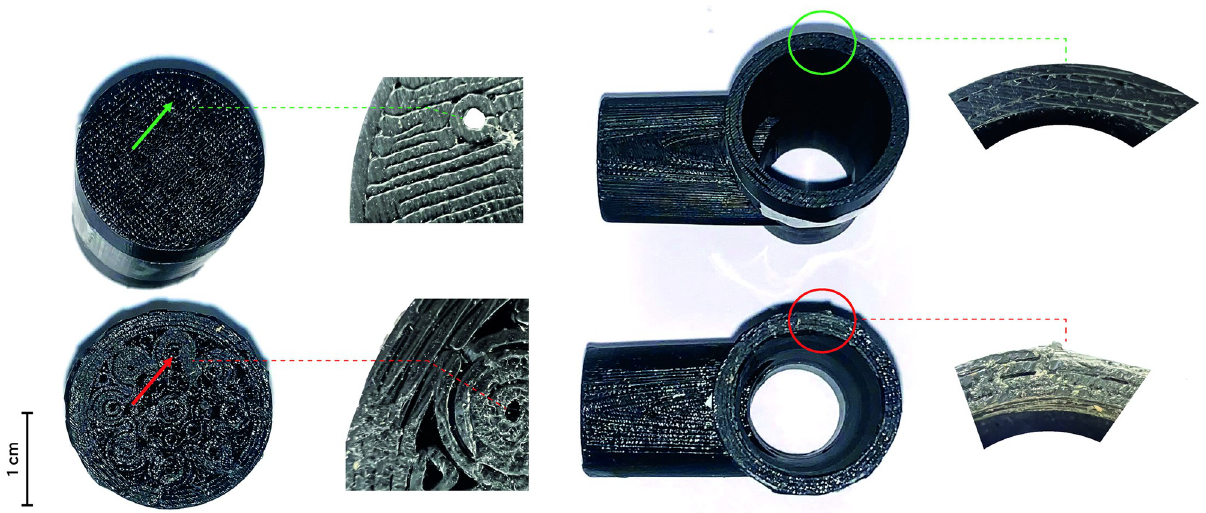
Fig 5. (a) Right panel: effects of coating on intentional leaks. Green arrow: reference 1 –F22 fitting, thin walls (0.7 mm), without coating, showing open perforations designed to allow intentional leaks. Red arrow: reference 1 –F22 fitting, thick walls (2.3 mm), with coating, showing obliterated perforations designed to allow intentional leaks. (b) Left panel: effects of coating on junctions. Green circle: reference 7 –M22M22M22T fitting, thick walls (2.3 mm), without coating showing clean surfaces at junction (green circle). Red circle: reference 8 –M22M22M22T fitting, thick walls (2.3 mm), with coating showing irregular surfaces at